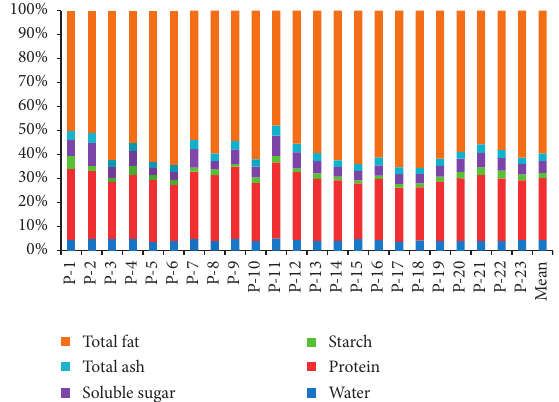
Figure 2: The content of water, protein, starch, soluble sugar, total ash, and total fat of hazelnut kernel from different areas (Northeast of China). Each value is a mean of three